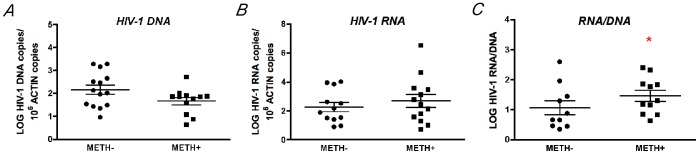
Increased HIV-1 transcription in the brains of METH-user HIV seropositive subjects.The content of HIV DNA and cellular HIV RNA was profiled in the frontal cortex area of HIV seropositive individuals with and without history of METH use, by real-time PCR and normalized to Actin or GAPDH levels respectively. A. and B. HIV-1 DNA and cellular HIV RNA did not show significant changes among groups. C. HIV-1 RNA/DNA ratio (as a marker of average HIV transcription) was significantly higher in METH user group, suggesting increases on viral transcription in the brain. *p<0.05 by Mann Whitney pairs test.